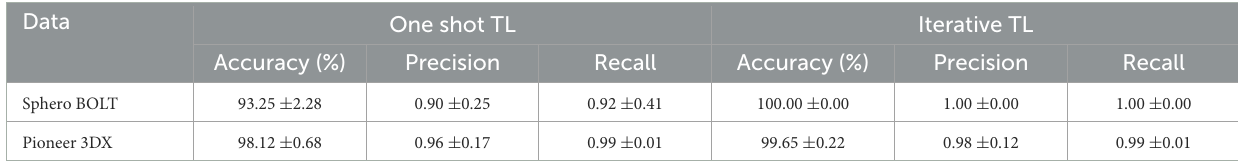
TABLE 3 Performance of collective motion recognition on transferred Sphero and Pioneer 3DX data using Knowledge-base of Section